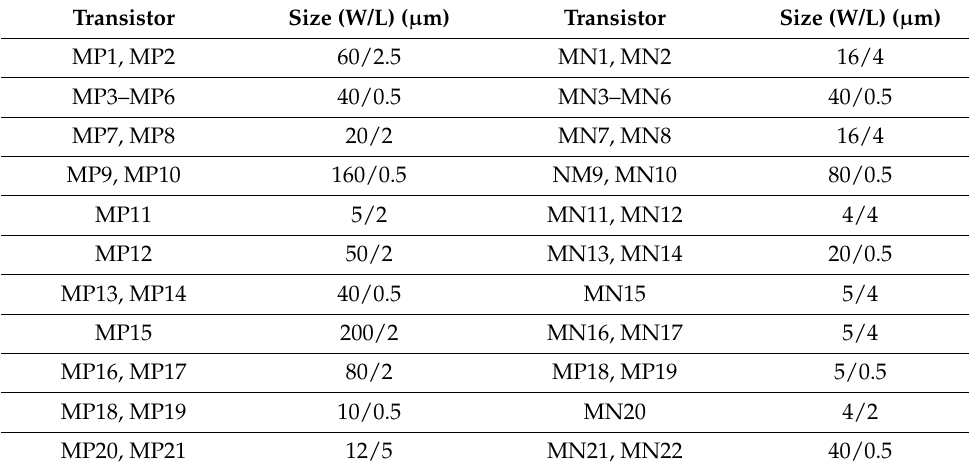
Table 1. Values of transistors in the proposed FDDA.